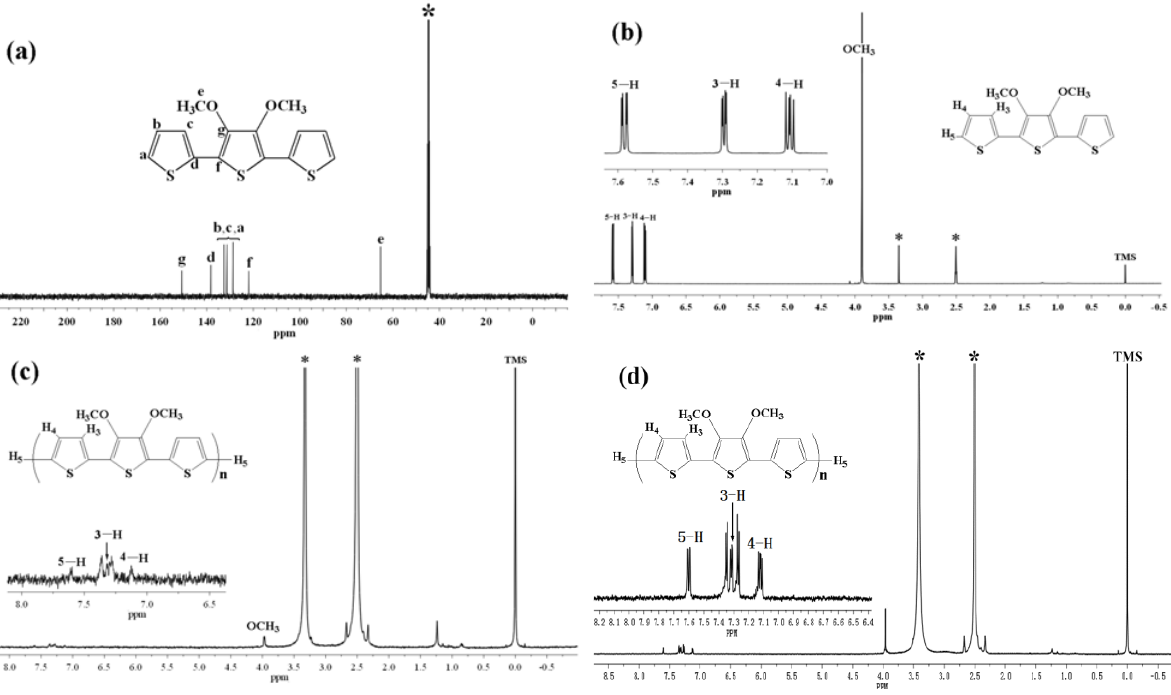
; 6 ; Starred peaks 6